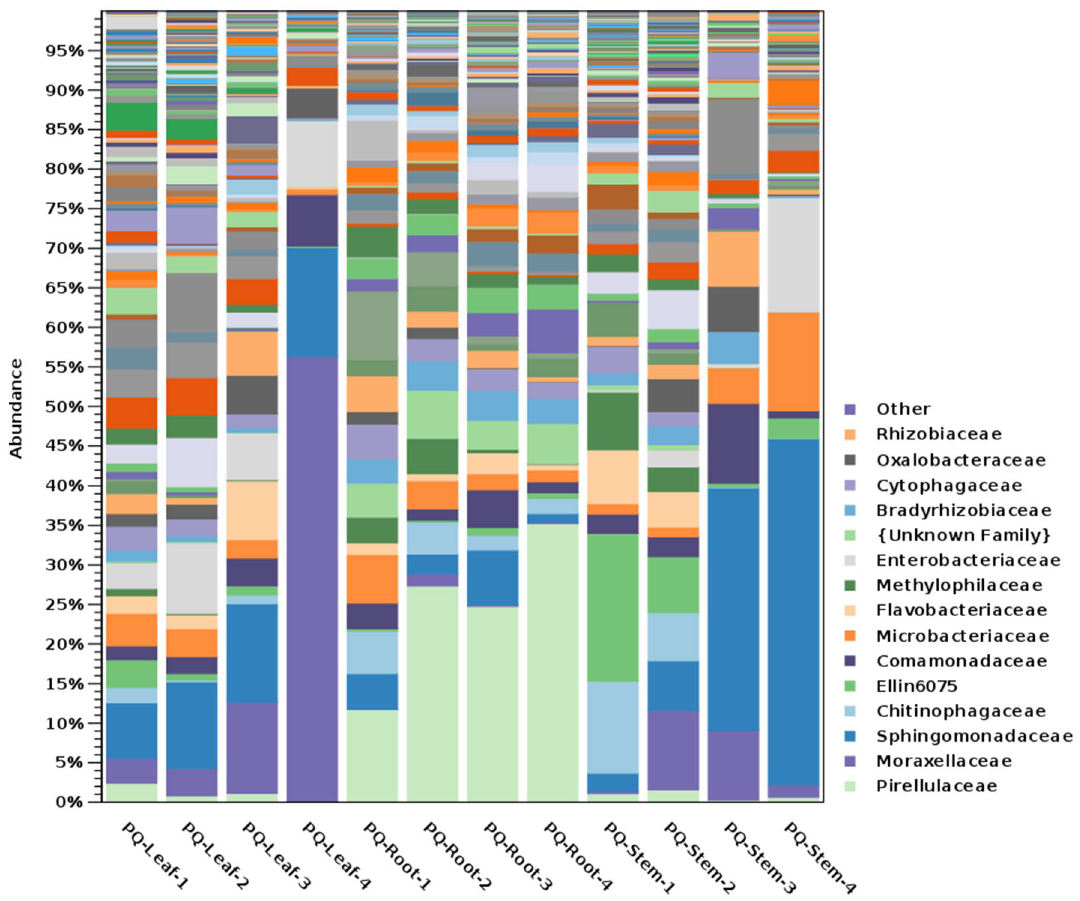
Figure 8. Taxonomic abundance of bacterial families in Panax quinquefolius